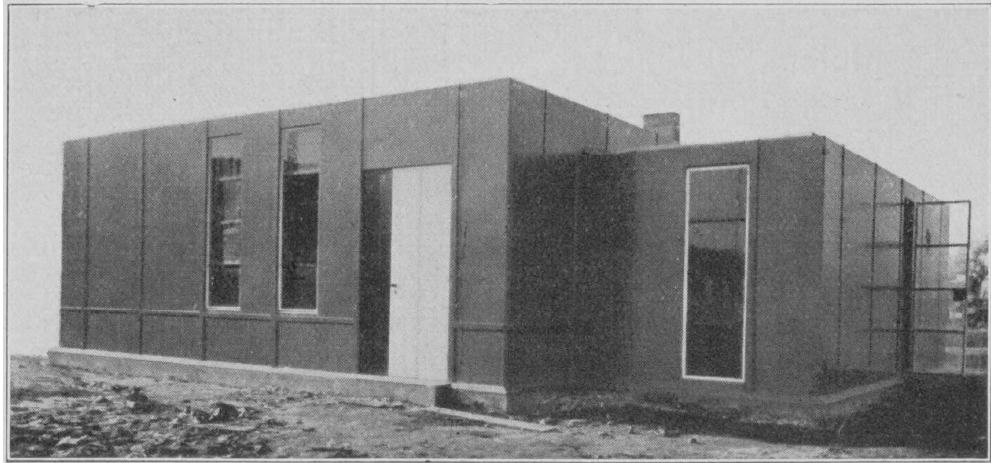
Figure 9. Georg Muche and Richard Paulick: Steel House in Dessau-Törten, 1926. Image taken from (Muche 1927b, p. 4).